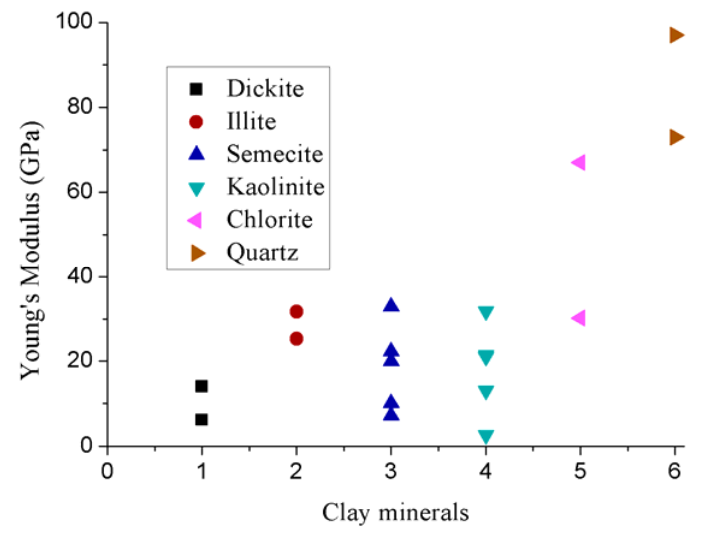
Figure 7 . Elastic properties of clay minerals [70–75]. Figure 7. Elastic properties of clay minerals